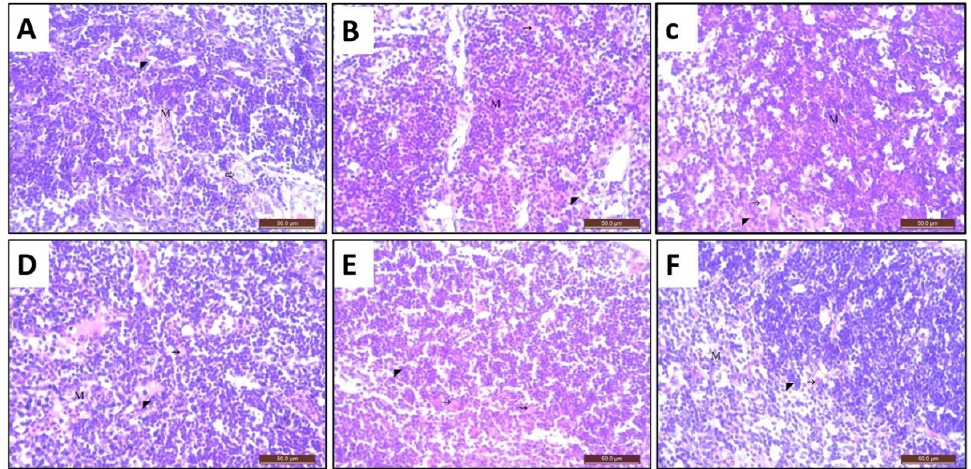
Figure 10. Photomicrographs of sections of the thymus stained with H/E ×400 from different groups. ( A ): (Control group) shows medulla, epithelioreticular cells (arrowhead), and Hassal’s corpuscle ( → ). ( B ): (OLE group) is similar to control group. ( C ): (Cis group) shows obvious spaces in the medulla due to decreased density of lymphocytes. ( D ): (Cis + OLE group) shows increased lymphocytes density more than that in Cis group. ( E ): (Cis + CM-MSC group) shows increased lymphocytes density but less than that in Cis + MSC group. ( F ): (Cis + MSC group) shows less lymphocytes density than that in control group, but more than that in Cis group.